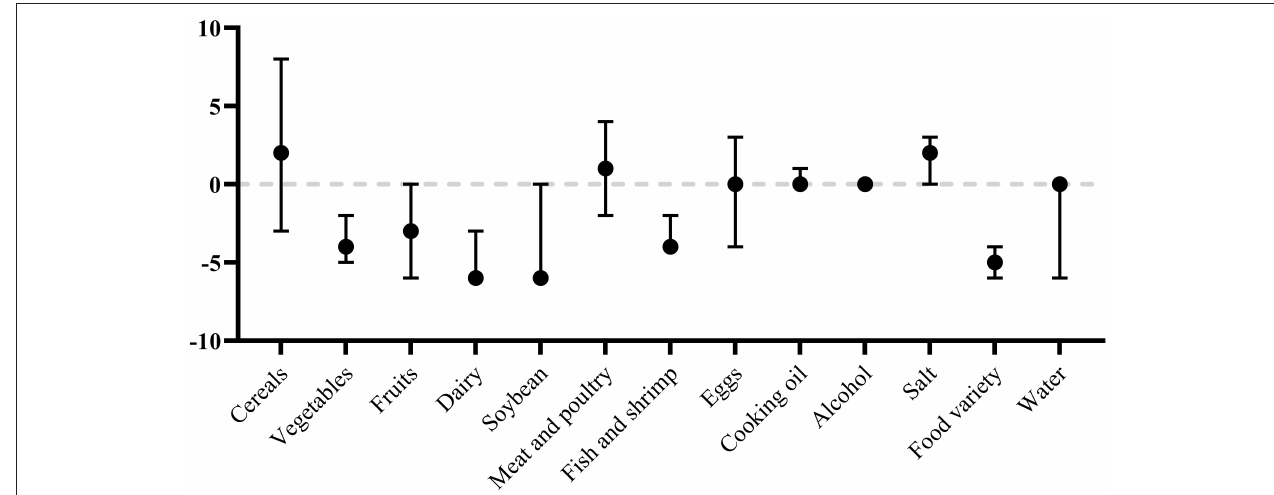
FIGURE 1 | Scores [Median (25th, 75th)] for the DBI components.